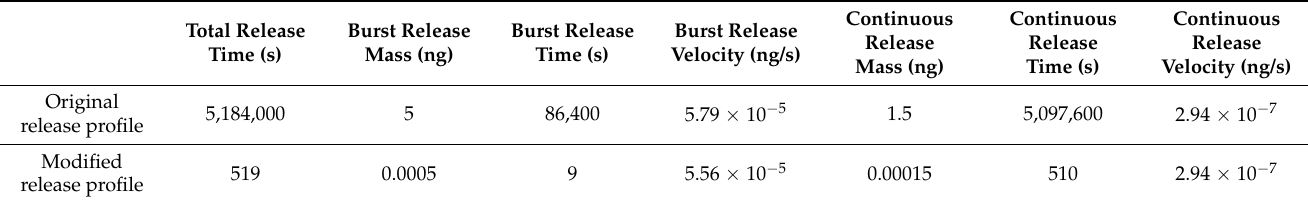
Figure 3. GDNF volume fraction of different drug release systems under the assumption of constant simulation time (519 s). ( a ) Comparison among single- and double-layer microsphere and bulk hydrogel systems. ( b – e ) Comparison within single-layer microsphere system only. ( f ) Comparison between three drug release systems and the combined model. Table 1. Illustration of how to narrow down the growth factor release